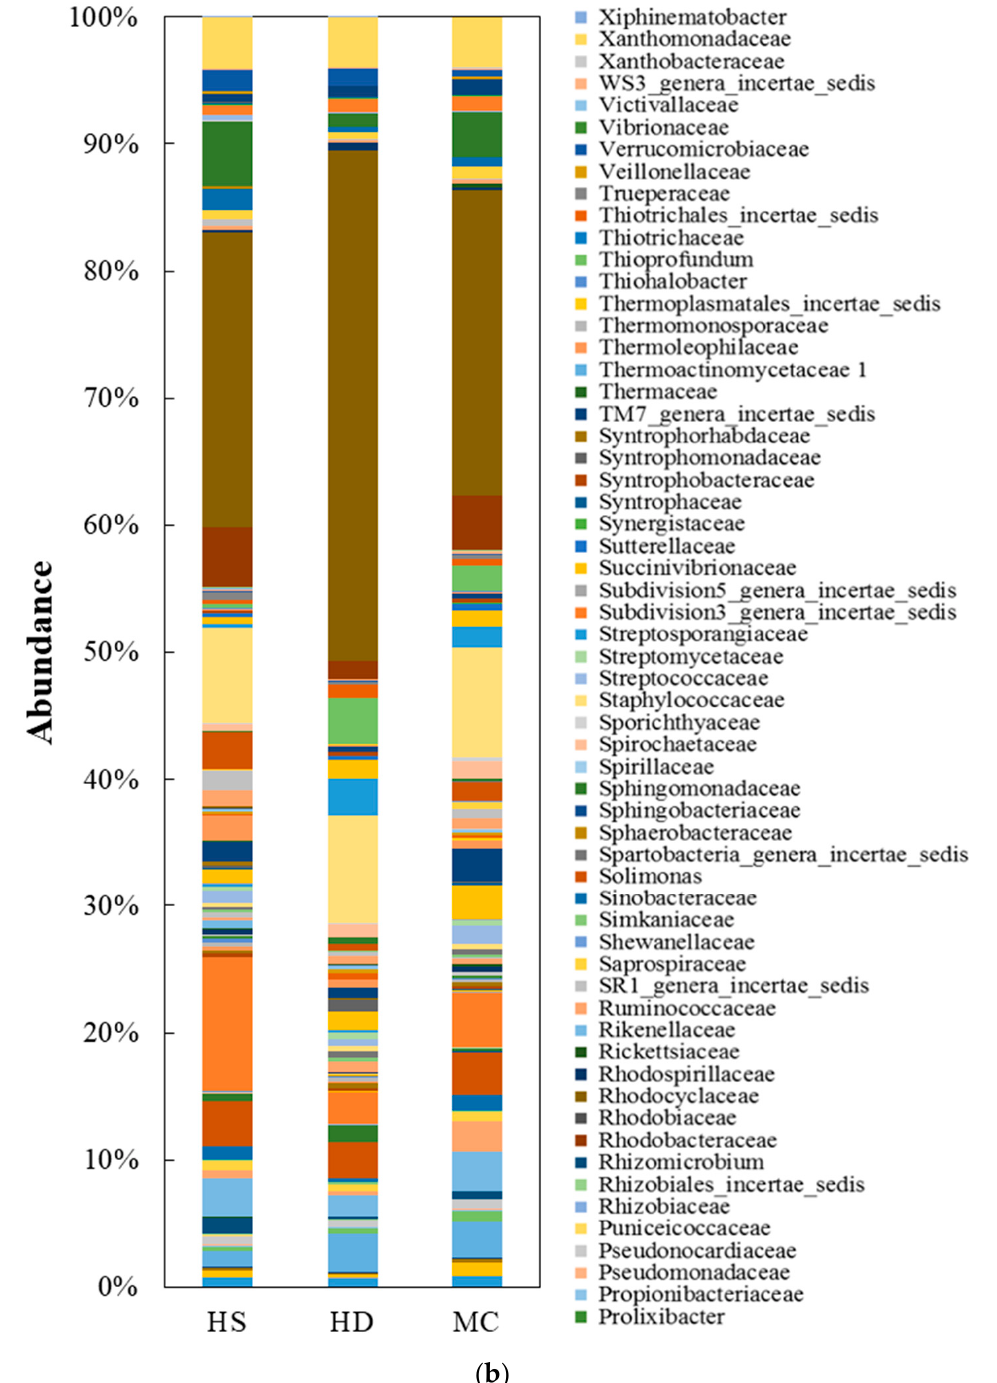
Figure 15. ( a ) Microbial community structure at the phylum level; ( b ) Microbial community structure at the family level.